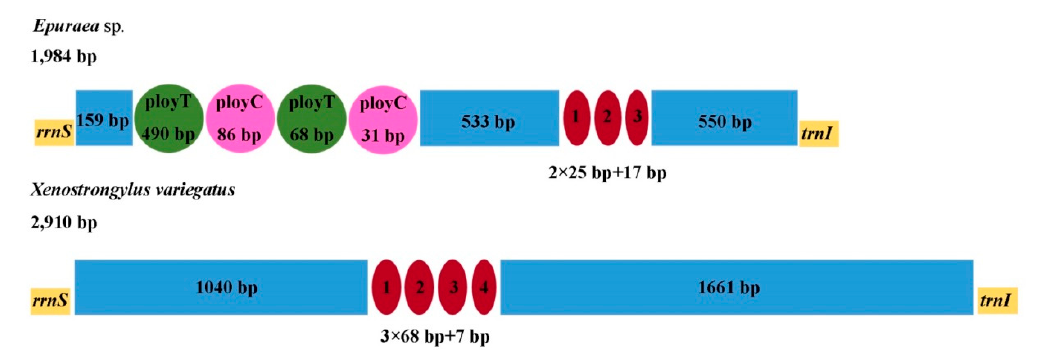
14 of 19 Figure 5. Inferred secondary structure for the tRNAs of Epuraea sp.